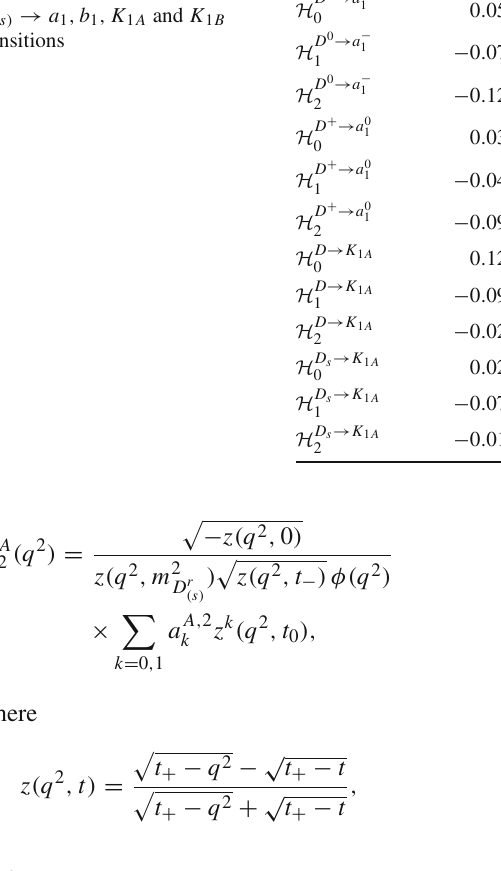
Table 4 Values of b 0 , b 1 and b 2 related to F ( 1 ) ( q 2 ) for the fitted form factors of D ( s ) → a 1 , b 1 , K 1 A and K 1